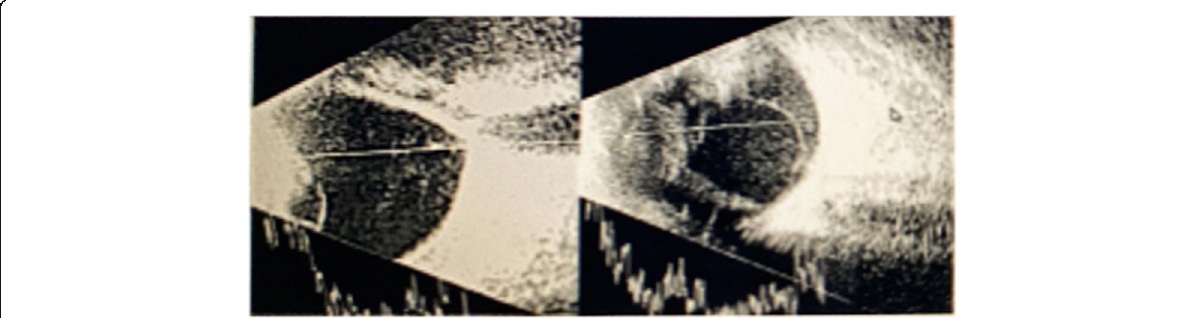
Fig. 2 B-scan ocular ultrasonography shows medium to highly reflective floaters and membranous echoes with loculated opacities in the vitreous cavity more condensed posteriorly with choroidal